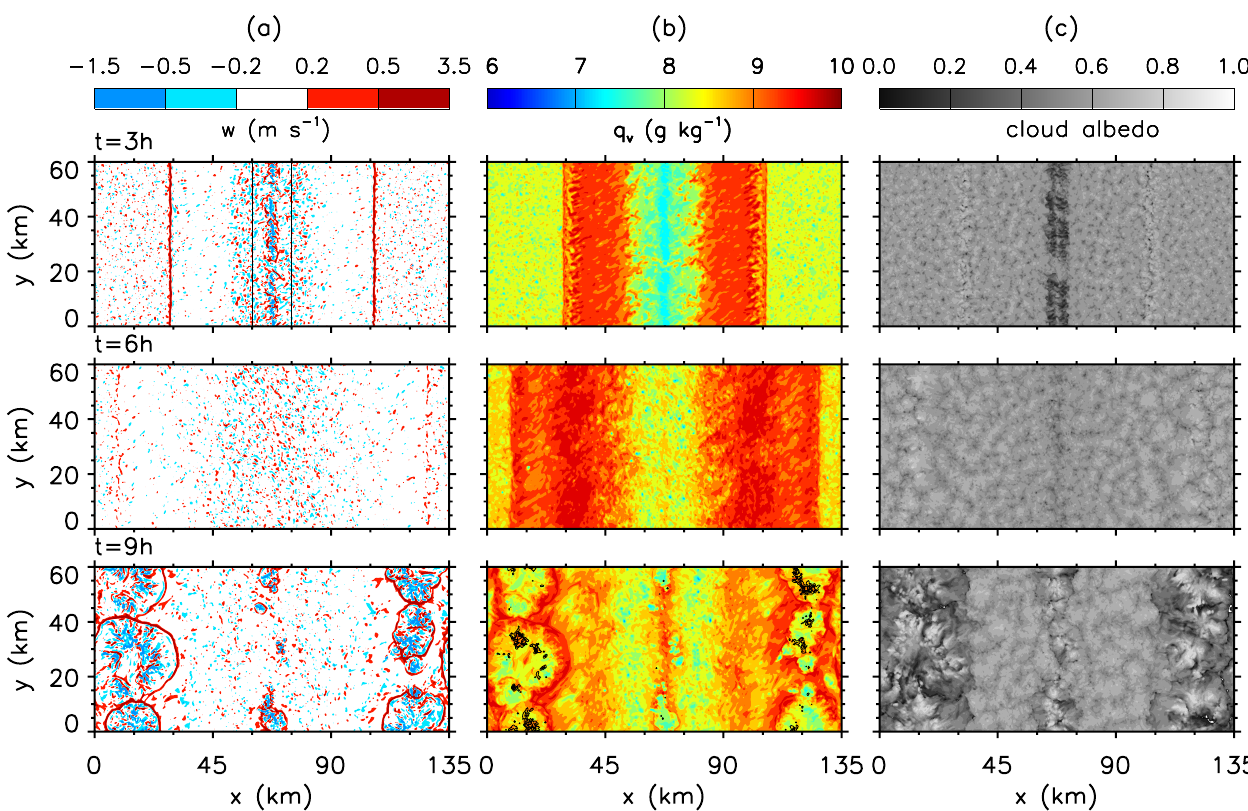
Fig. 11. Snapshots of (a) 200-m vertical velocity w , (b) 200-m water vapor mixing ratio q v , and (c) cloud albedo at t =3, 6 and 9h (corresponding to each of the three rows) from experiment CTRL-QVT2; contours of rain rate (0.2, 5, and 20mmday − 1 ) are superimposed on the q v fields. Initial perturbations are applied to the 15-km strip marked in the upper-left